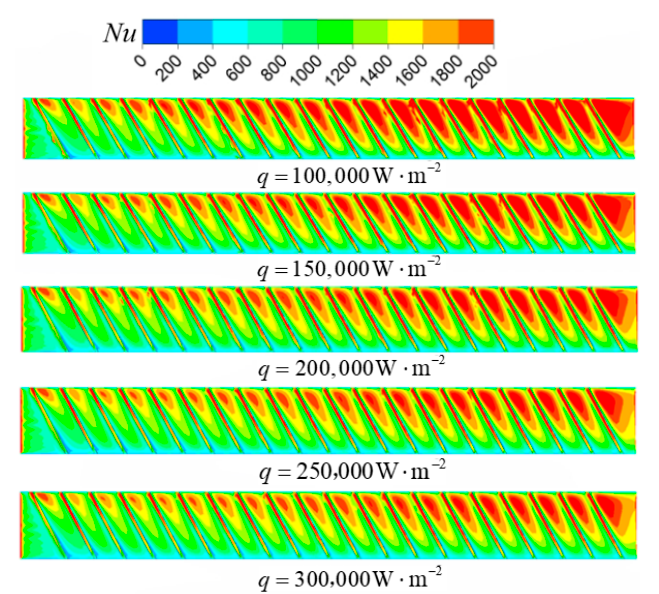
Figure 15. Variation in the Nusselt number distribution of the mist/steam cooling channel with the wall heat flux density.